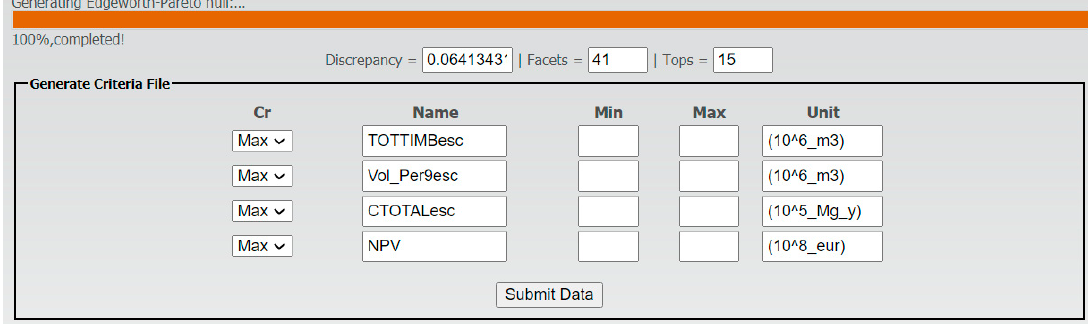
Figure 10. Interactive decision map showing the tradeoff between four criteria: volume of ending inventory (10 6 m 3 ; Vol_Per9esc) in the y -axis; total wood (10 6 m 3 ; TOTTIMBesc) in the x -axis; the chosen level of average carbon sequestered (Mg year − 1 ; CTOTALesc) in the first slider (4.17 Mg year − 1 ) and the chosen level of net present value level (10 8 EUR; NPV) in the second slider (0.64 10 8 EUR).